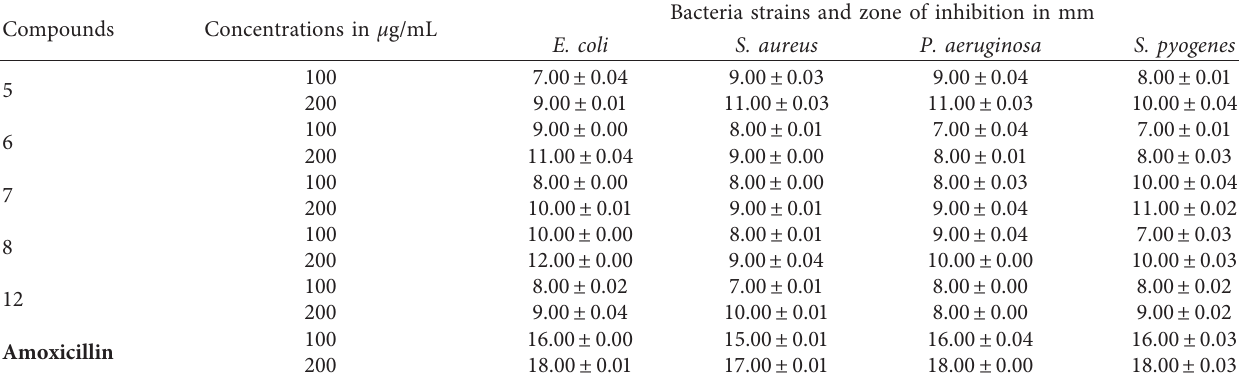
Results are mean ± SD of duplicate experiments. Amoxicillin was used as a positive control.